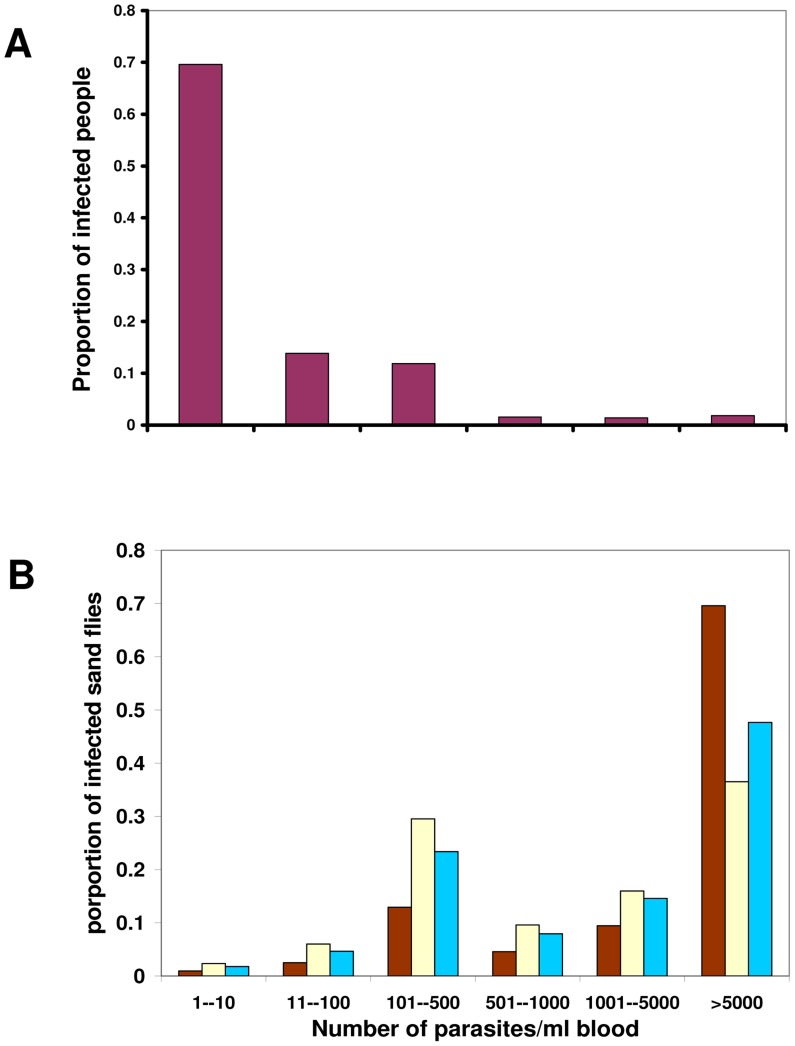
The contribution of asymptomatic carriers with different parasitemias to the infected sand fly population.(A) Division of the infected human population into parasitemia categories. Bars represent the proportion of the different parasitemias among the total infected human population (N = 658). Due to a large sample size (N = 658), the errors were of the order of 1% and hence negligible. (B) The calculated proportions (according to equation 5) of infected sand flies (from all infected sand flies) that were infected by feeding on individuals belonging to different parasitemia categories. Grouped bars represent the proportions of flies infected by biting people that belong to a particular parasitemia category (X axis). Different colored bars represent the proportion of infected sand flies (from all infected sand flies) for three different values of the model parameters, λ1 and λ2: mean, and the two edges of their 95% confidence intervals (the confidence intervals were calculated by parametric bootstrapping on Figure 1A
 data). Note that for high estimations of λ1 and λ2 (and hence q(n)), the relative contribution of people with low parasitemias to the population of infected sand flies would be larger compared to the case of low λ1 and λ2 (i.e., low q(n)).